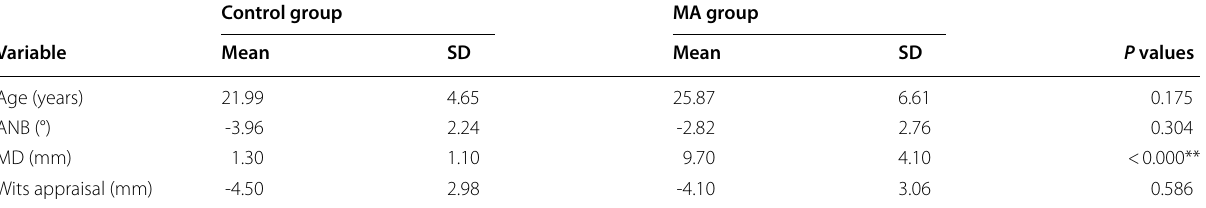
SD Standard deviation, MD Degree of menton deviation ** P < 0.01